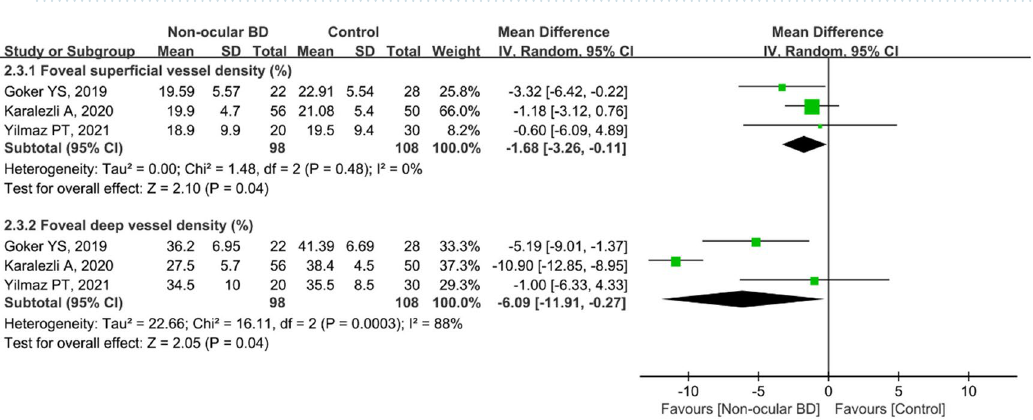
Figure 7. Forest plot analysis of foveal superficial and deep vessel density in non-ocular BD patients and